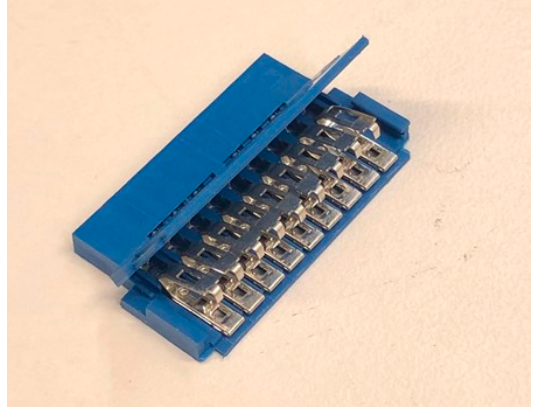
Figure 7. A robust 2.54 mm (nine-way female) Amphenol connector.